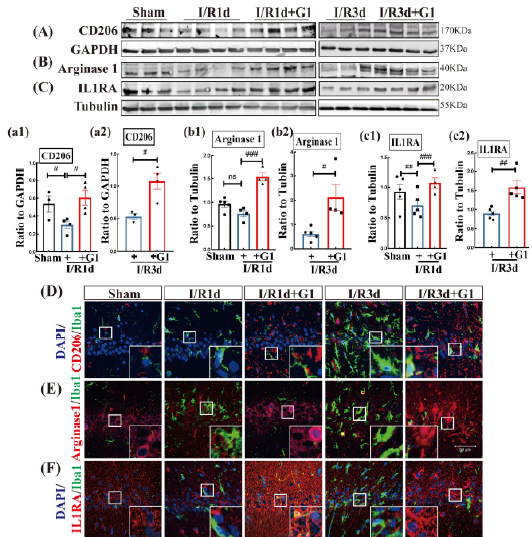
Figure 2. G1 administration enhanced M2 phenotypic marker proteins of microglia in the ovariec ‐ tomized rat hippocampal CA1 region following GCI. Western blot analysis results of M2 markers CD206 ( A , a1 , a2 ), Arginase 1 ( B , b1 , b2 ), and IL1RA ( C , c1 , c2 ) are shown. Coronal brain sections were subjected to double immunofluorescence staining of Iba1 (green) and ( D ) CD206 (red), ( E ) Arginase 1 (red), and ( F ) IL1RA (red). DAPI (blue) was used to stain the nuclei. Data are shown as the means ± SEs from three to five independent samples per group ( n = 3–5). # p < 0.05, ## p < 0.01, and ### p < 0.001. ns, no significance. Scale bar, 50 μ m. Magnification, 40×. IL1RA, Interelukin ‐ 1 receptor antag ‐ onist; Iba1, Ionized calcium binding adaptor molecule 1. White Box in subfigure D ‐ F, GPER, G ‐ pro ‐ tein ‐ coupled estrogen receptor 1.